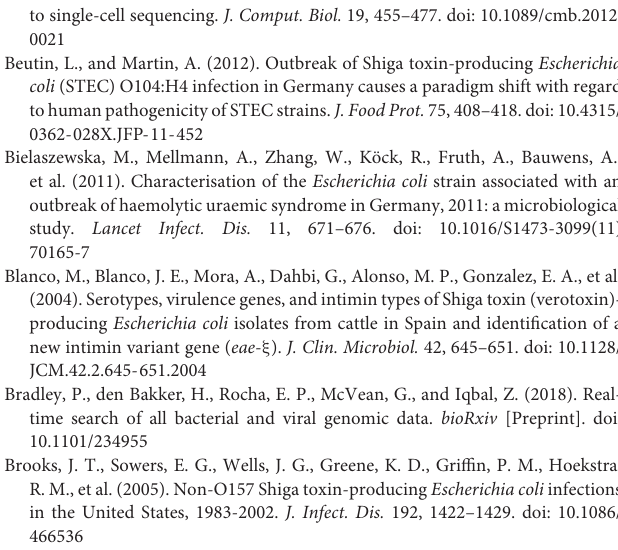
TABLE S1 | In silico genomes for tests with pipelines A+B. TABLE S2 | In silico genomes used from Refseq + GenBank. TABLE S3 | Results primer BlastN against enterobacterial genomes. TABLE S4 | stx primer specificity test. TABLE S5 | Clinical isolates tested. TABLE S6 | Comparison pipeline A+B. TABLE S7 | CC11 and CC20 markers detected by pipeline